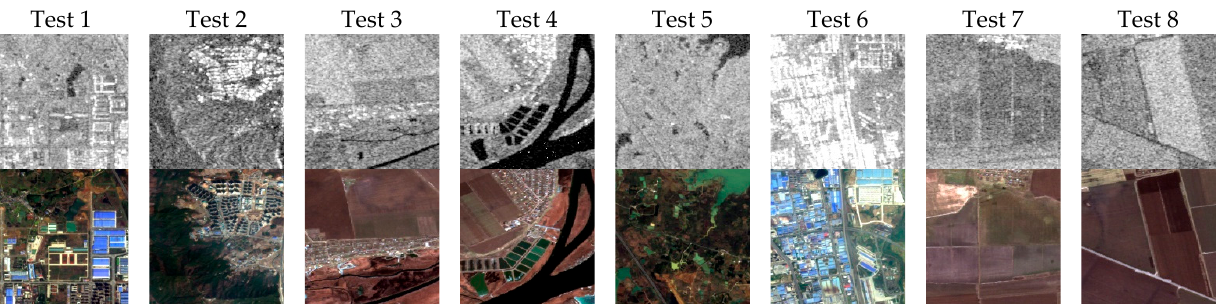
Figure 6. Some of the image blocks were selected as test samples. First row: SAR image blocks. Second row: optical image blocks.